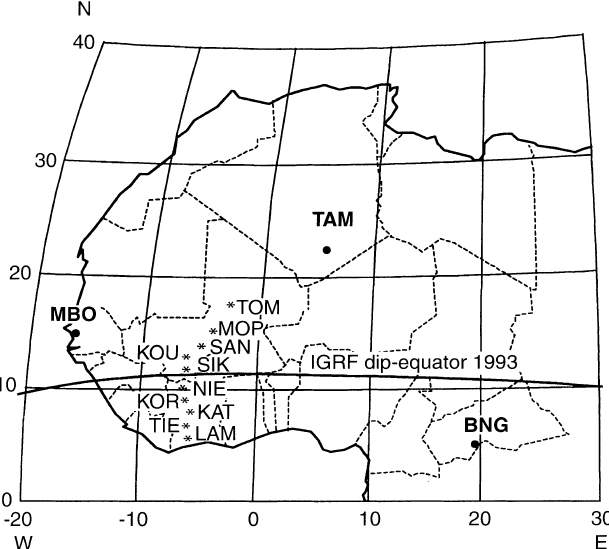
Fig. 1. Geographic positions of stations established along meridian 5 (cid:176) W, across the dip equator which is determined from IGRF at the 1993.5 epoch. Stations are represented by their first three letters (see Table 1)